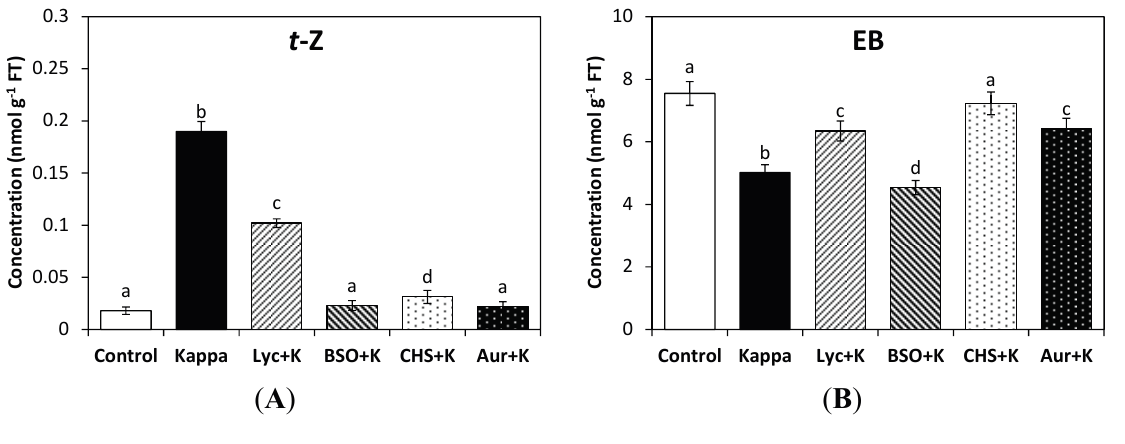
Figure 2. Level of trans -zeatin ( t -Z, A ) and epibrassinolide (EB, B ) in control Eucalyptus trees (control), in trees treated with OC kappa (kappa) and in trees treated with lycorine and OC kappa (lyc + kappa), buthionine sulfoxime (BSO + kappa), CHS-828 and OC kappa (CHS + kappa) and auranofine and OC kappa (aur + kappa) cultivated for 4 additional months without additional treatment. The level of t -Z and EB is expressed in nanomoles per gram of fresh tissue (FT). Bars indicate mean values of three independent experiments and different letters significant differences ( p <